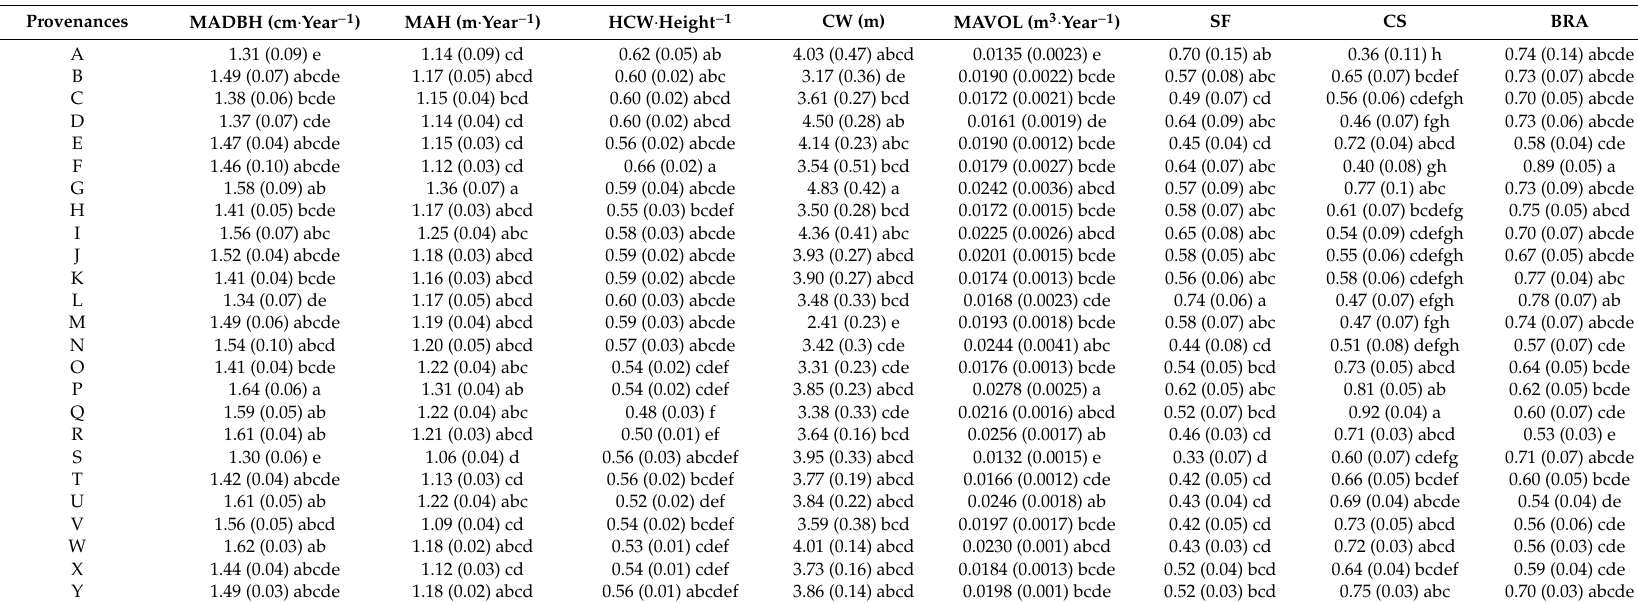
Table A4. Growth and quality traits for 25 provenances of Betula alnoids at Hua’an